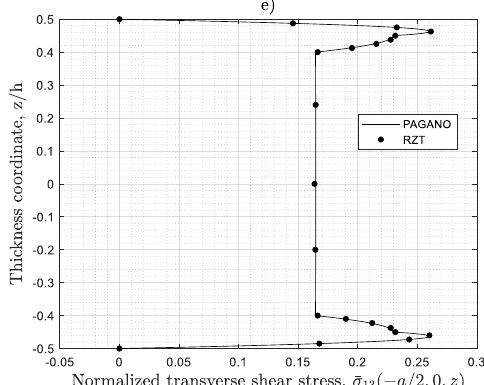
Figure 6. Bending of a square sandwich plate (S), simply supported on all edges under transverse sinusoidal pressure (span-to-thickness ratio, a / h = 6). ( a ) Normalized in-plane displacement ( u 1 ) ; ( b ) Normalized transverse displacement ( w ) ; ( c ) Normalized in-plane stress ( σ 11 ) ; ( d ) Normalized in-plane stress ( σ 22 ) ; ( e ) Normalized transverse shear stress ( σ 13 ) .